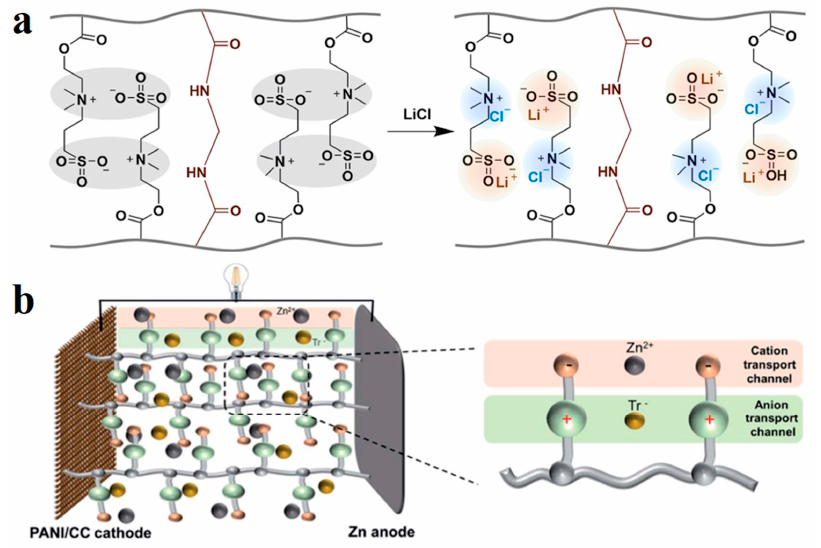
Figure 4. ( a ) Mechanism of LiCl blocking polymer chain association. Reprinted with permission from Reference [71]. ( b ) Simulation diagram of independent anion and cation transport channel. Reprinted with permission from Reference [72].